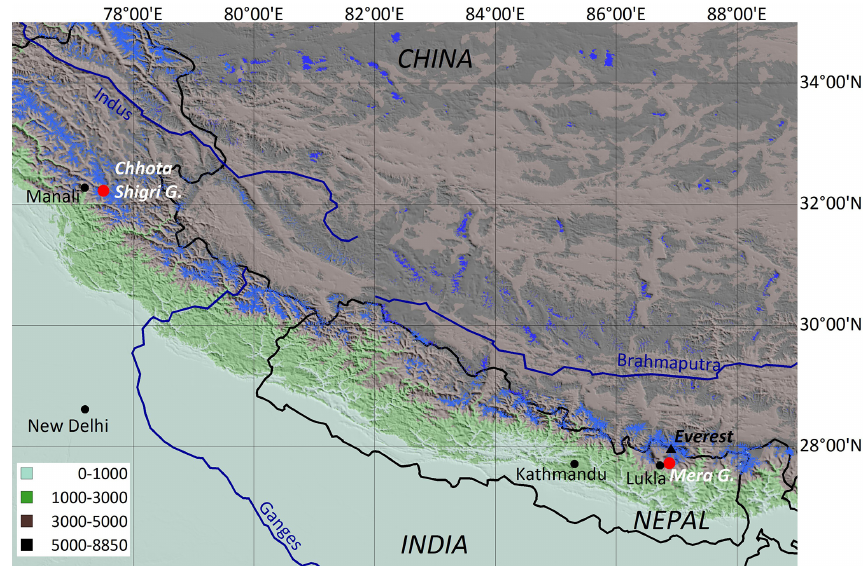
Figure 1. Map of the study area. The altitude ranges given in the legend are in meters. The glacierized areas (from the Randolph Glacier Inventory version 3.2, Pfeffer et al. (2014)), are in blue and the two studied glaciers are represented by red